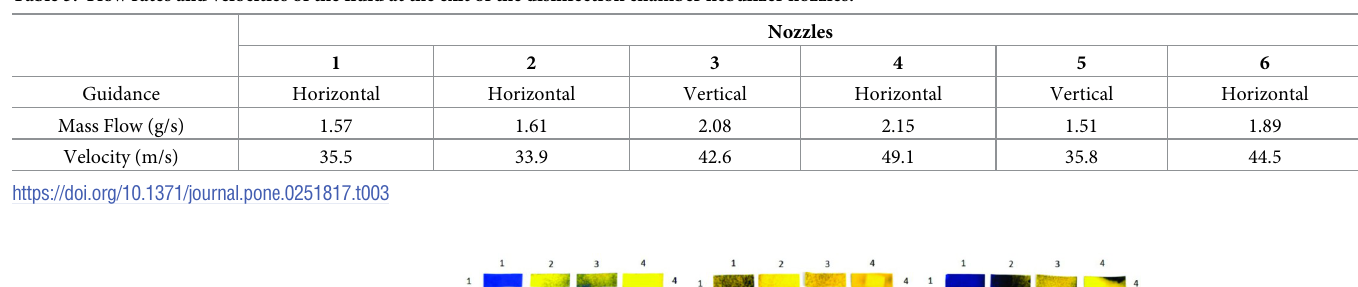
Table 3. Flow rates and velocities of the fluid at the exit of the disinfection chamber nebulizer nozzles.